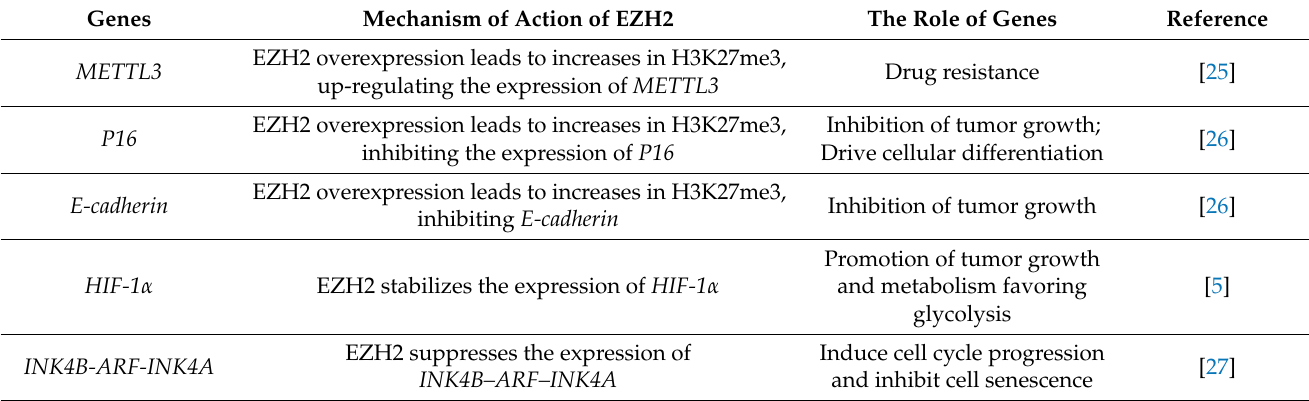
Table 1. The genes that are regulated by EZH2 through histone